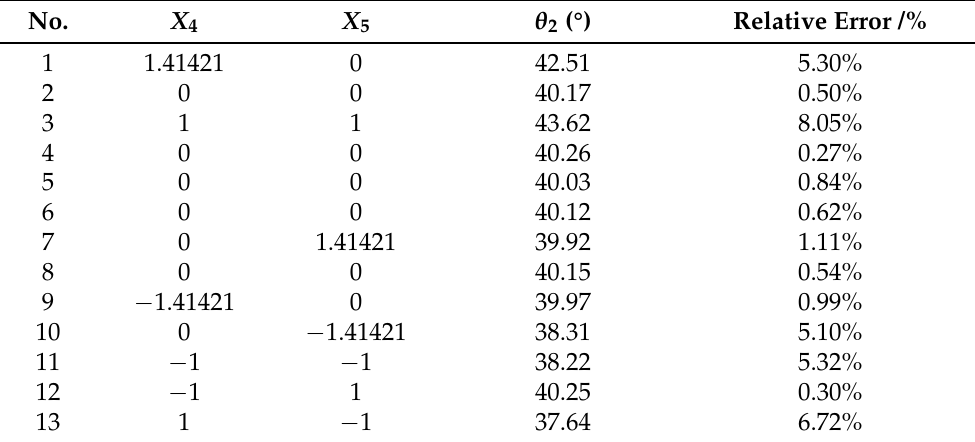
Table 9. Central Composite Design and results.